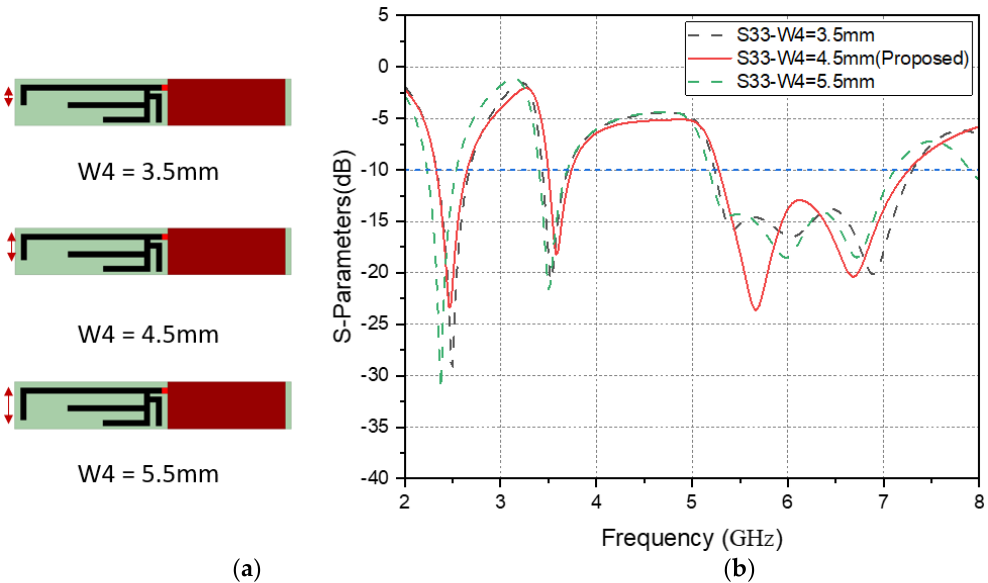
Figure 8. ( a ) Schematic diagram of W4 length variation of Ant. 3, ( b ) reflection coefficient (|S33|) of W4 length variation.